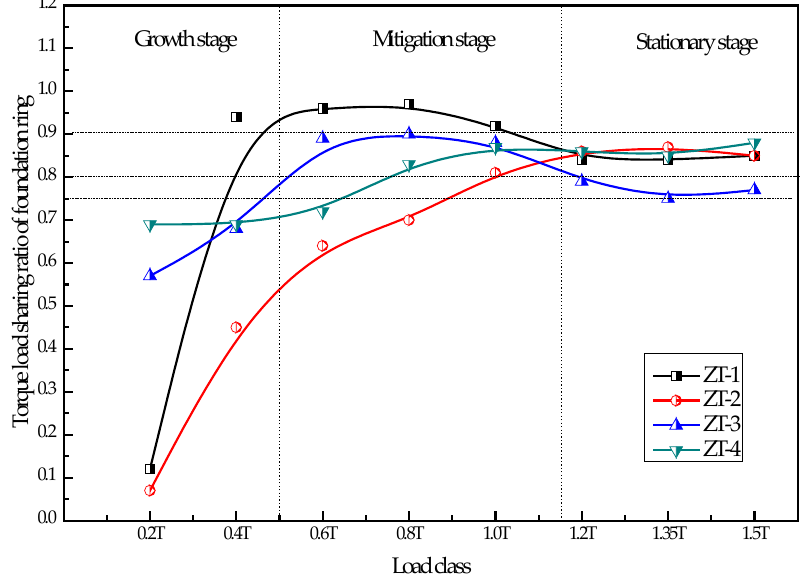
Figure 16. Torque load sharing ratio of the four specimens.